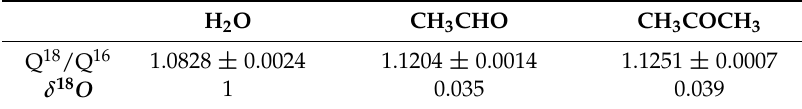
Table 1. Computed ratio of partition functions and 18 O enrichments of CH 3 CHO and CH 3 COCH 3 in